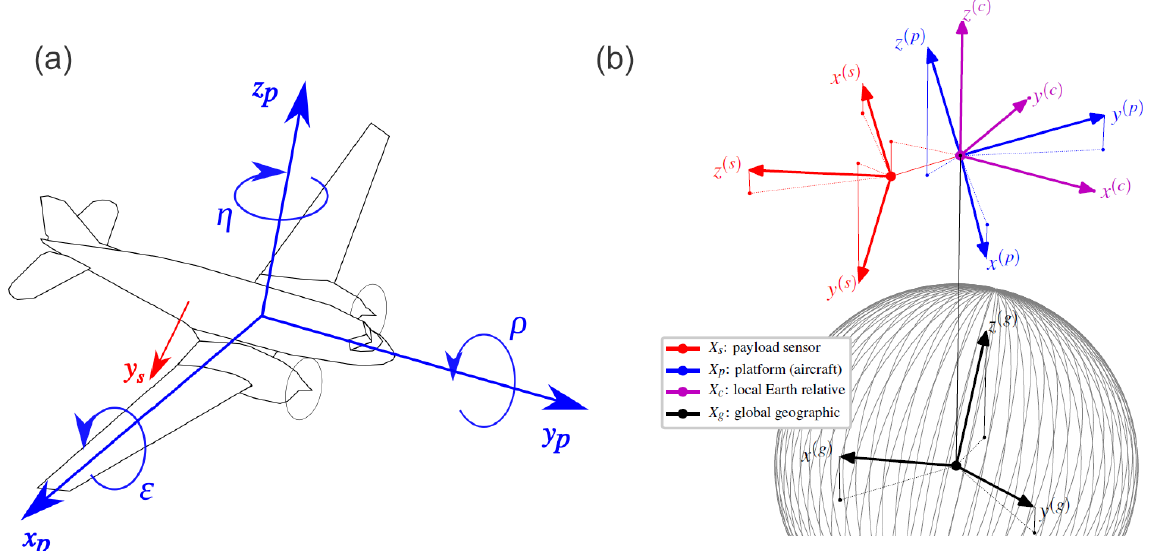
Figure 6. (a) Sketch of the Polar 5 aircraft and the platform-relative X p reference frame. (b) Reference frames for airborne measurements: sensor-relative X s (red), platform-relative X p (blue), local Earth-relative X c (purple), and global geographic (black). The grey lines are meridians of X g and the sphere they indicate may be seen as the planet surface, but distances are obviously not to scale. In blue are coordinate axes of the aircraft reference frame X p and principal rotation angles: heading η , pitch (cid:15) , and roll ρ . In red is the y axis of X s